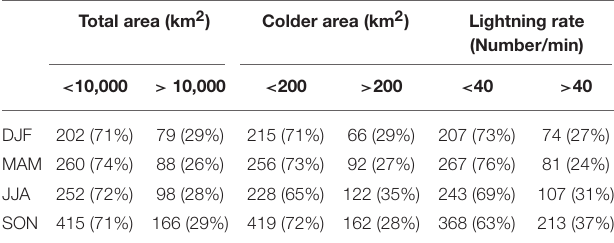
TABLE 3 | Features of potentially severe convection cases for each season.